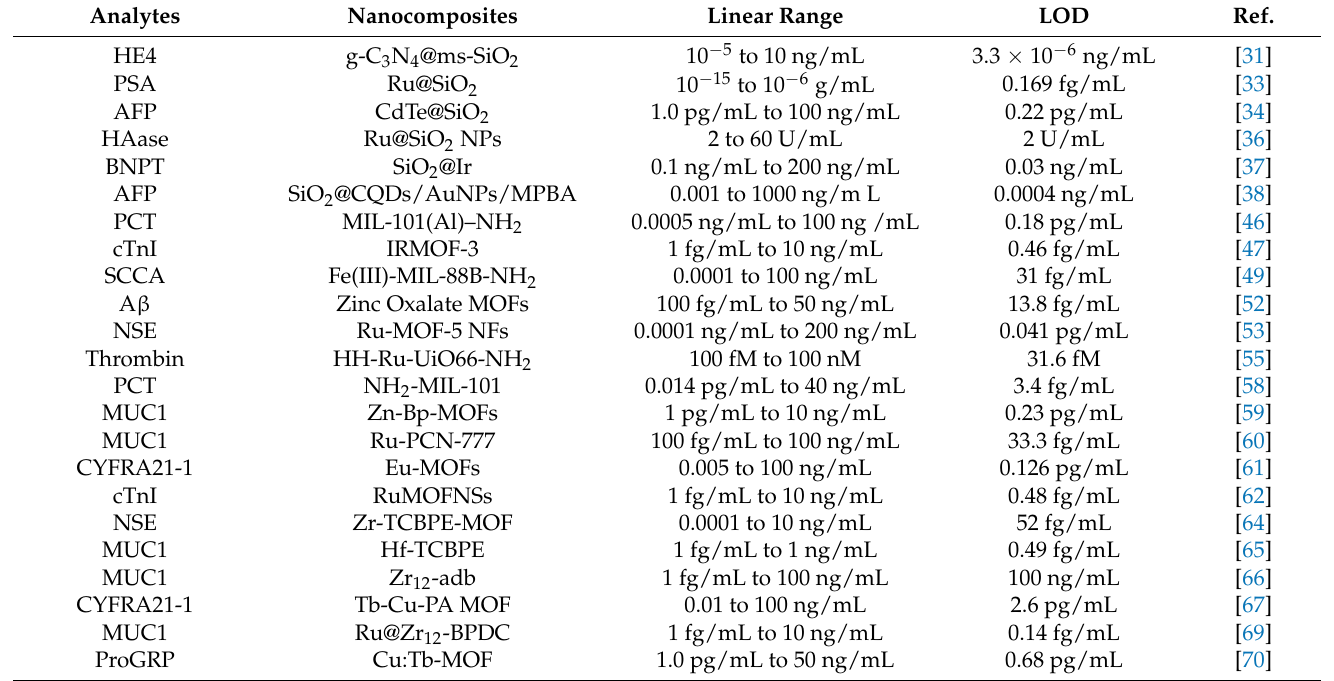
Table 4. Summary of the construction of ECL biosensors based on porous nanocomposites for protein